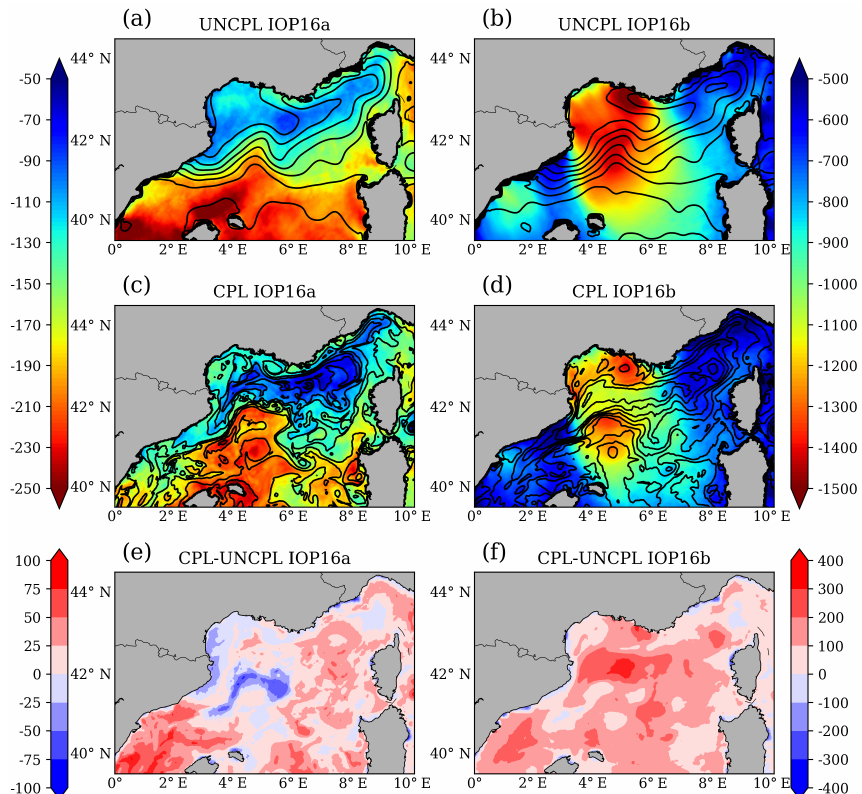
Figure 6. Spatial distribution of non-solar heat flux (Qns, Wm − 2 ) and SST in black contours (contour interval of 0.5 ◦ C) averaged over IOP16a (left) and IOP16b (right) for UNCPL simulation (a, b) , CPL simulation (c, d) and the difference between CPL and UNCPL (e, f)